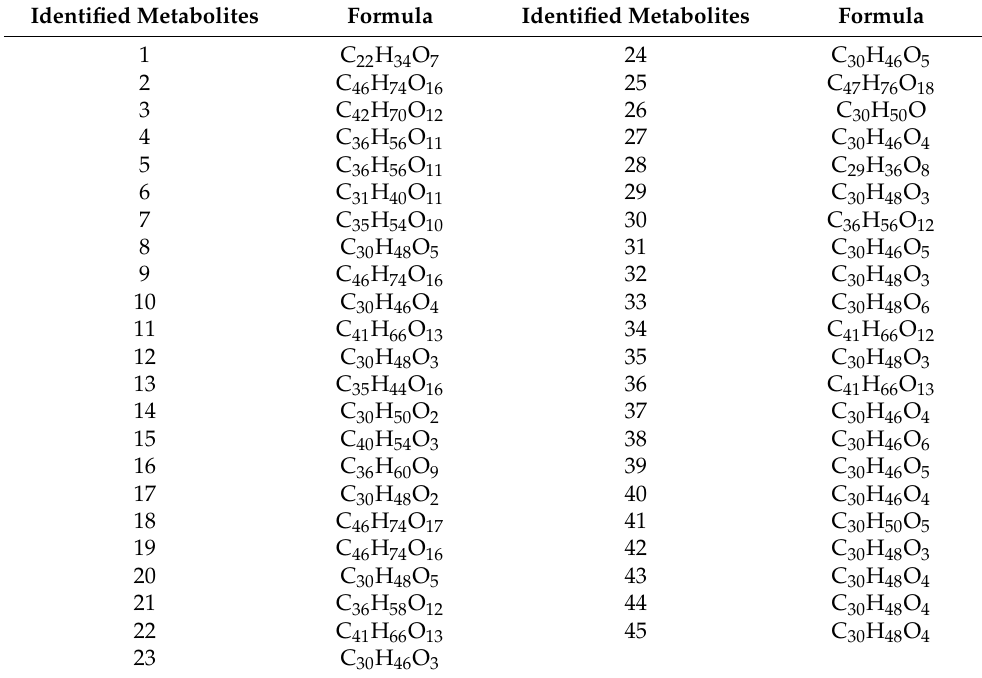
Table 1. Triterpenoid compounds identified in the fruit, pericarp, and seed of A. trifoliata (UHPLC- TOF-MS/MS) and metabolomic